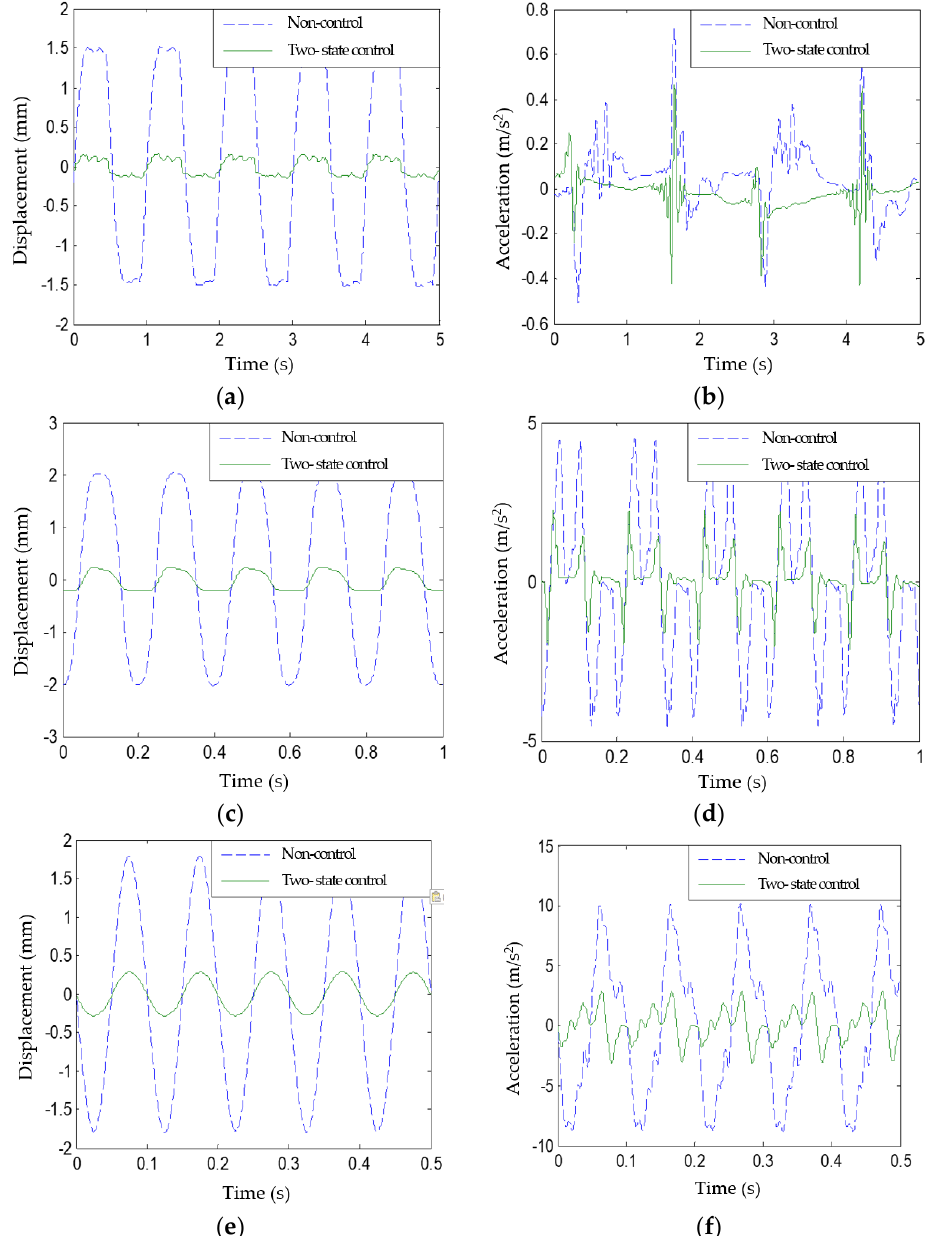
Figure 14. Pipeline vibration response under two-state control and excitation frequency of 1, 5, 10 Hz: ( a ) Displacement-time curve (1 Hz); ( b ) Acceleration-time curve (1 Hz); ( c ) Displacement-time curve (5 Hz); ( d ) Acceleration-time curve (5 Hz); ( e ) Displacement-time curve (10 Hz); ( f ) Acceleration-time curve (10 Hz)